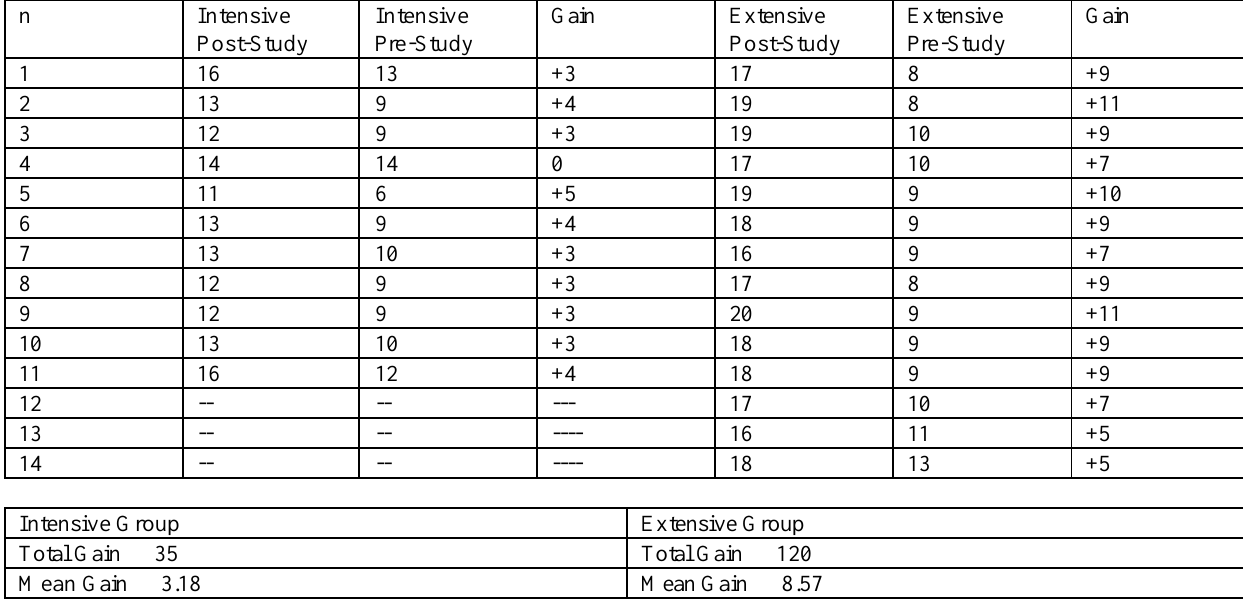
Table 4.10 Reading Comprehension – Analysis of Gains - Multiple Choice + True/False